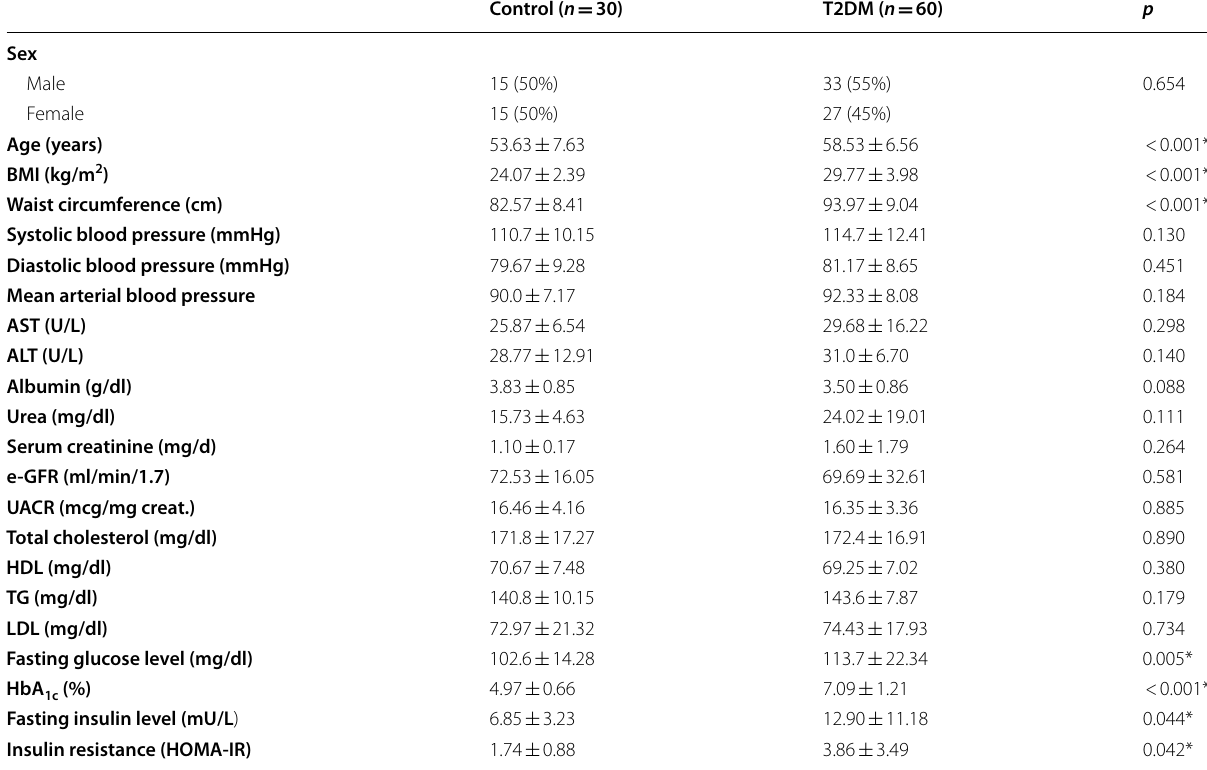
Table 1 Demographic data and laboratory results of the studied groups